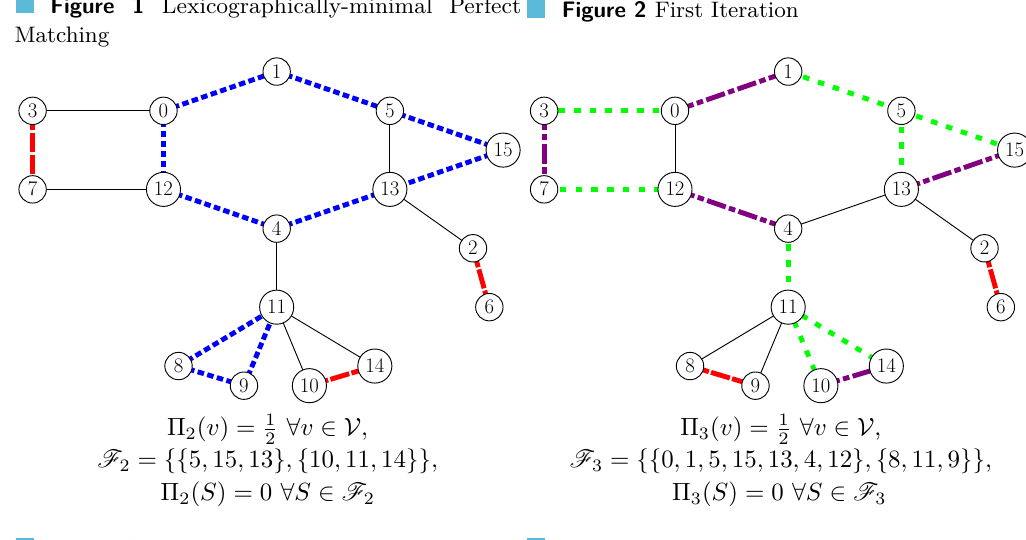
Figure 2 First Iteration